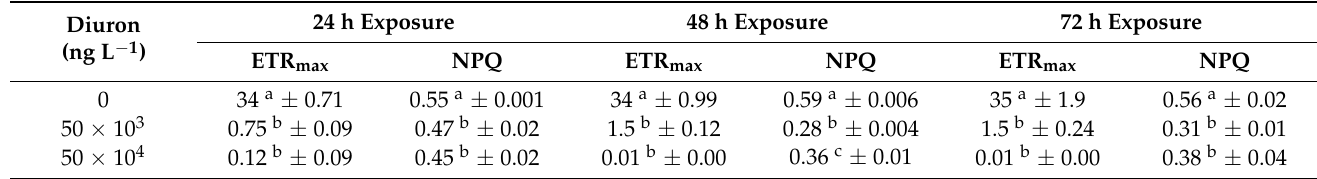
Table 2. Effect of diuron (50 × 10 3 and 50 × 10 4 ng L − 1 ) on induced chlorophyll a fluorescence parameters including maximum electron transport rate (ETR max ) and non-photochemical quenching (NPQ) in Lemna minor exposed for 24, 48, and 72 h. Data represent mean ± standard deviation of three replicates. Different letters indicate statistically significant differences at p < 0.05 (one-way ANOVA, LSD).